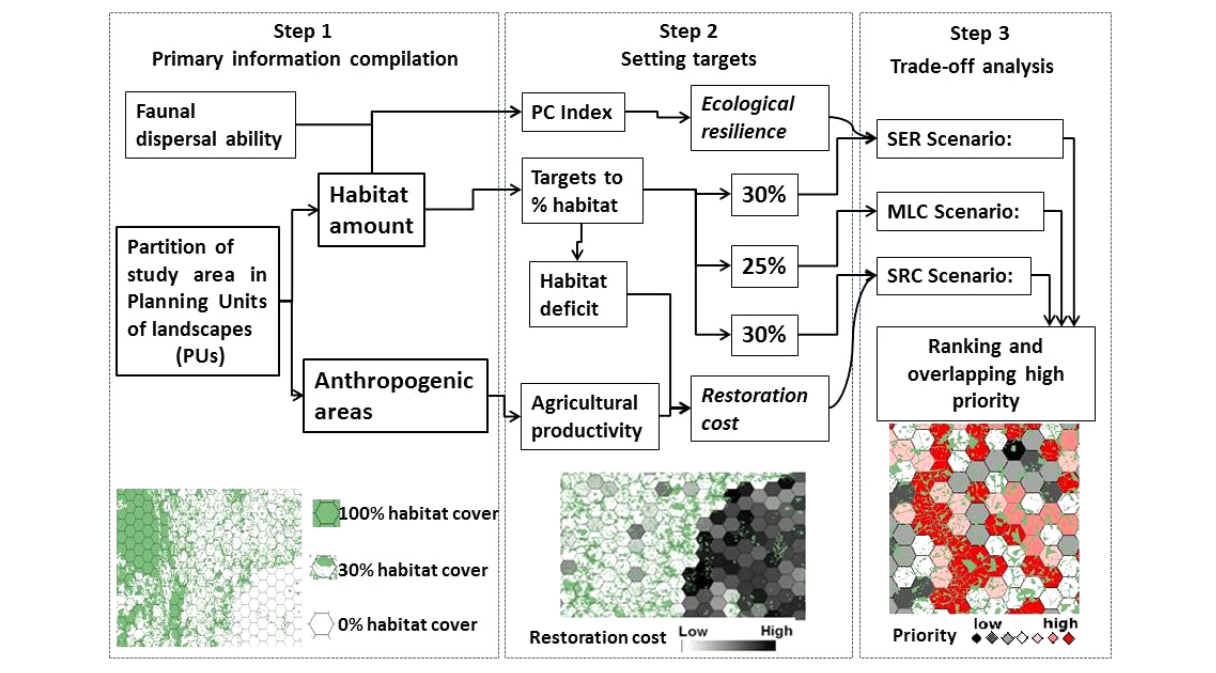
Fig. 2 . Steps of the methodological framework: (1) primary information compilation: (i) partition of study area into planning units (PUs), and (ii) quantification of anthropogenic and habitat areas from land use and land cover maps; (2) setting targets for the scenarios and calculation of ecological resilience and restoration cost; (3) scenario trade-off analysis, priority ranking, and overlapping between PUs from different scenario and high priority PU.